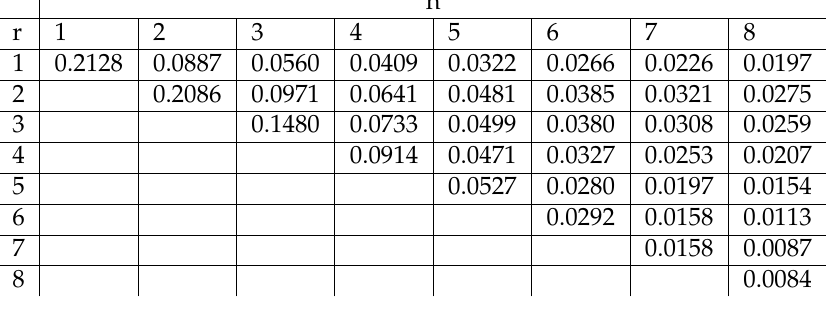
Table 4. Variances of gos from Pareto-Rayleigh distribution( α =2, σ =1, m =1, k